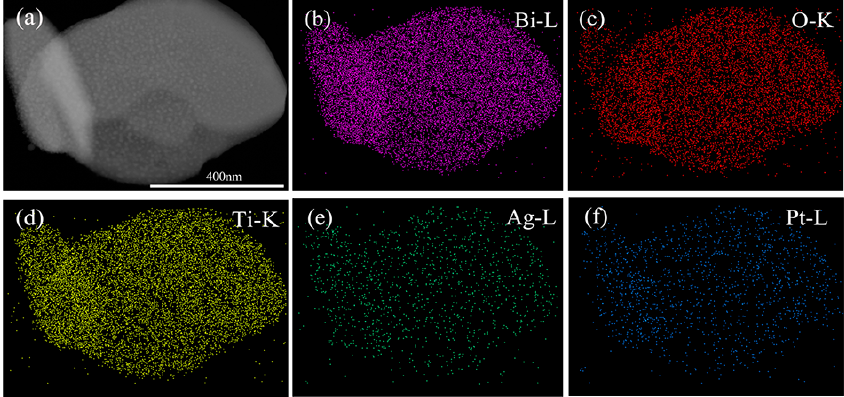
Figure 3. Transmission electron microscope (TEM) images ( a , c ), SAED image ( b ) and high-resolution TEM (HRTEM) image ( d ) of (Ag 0.7 Pt 0.3 ) 0.001 /Bi 4 Ti 3 O 12 .